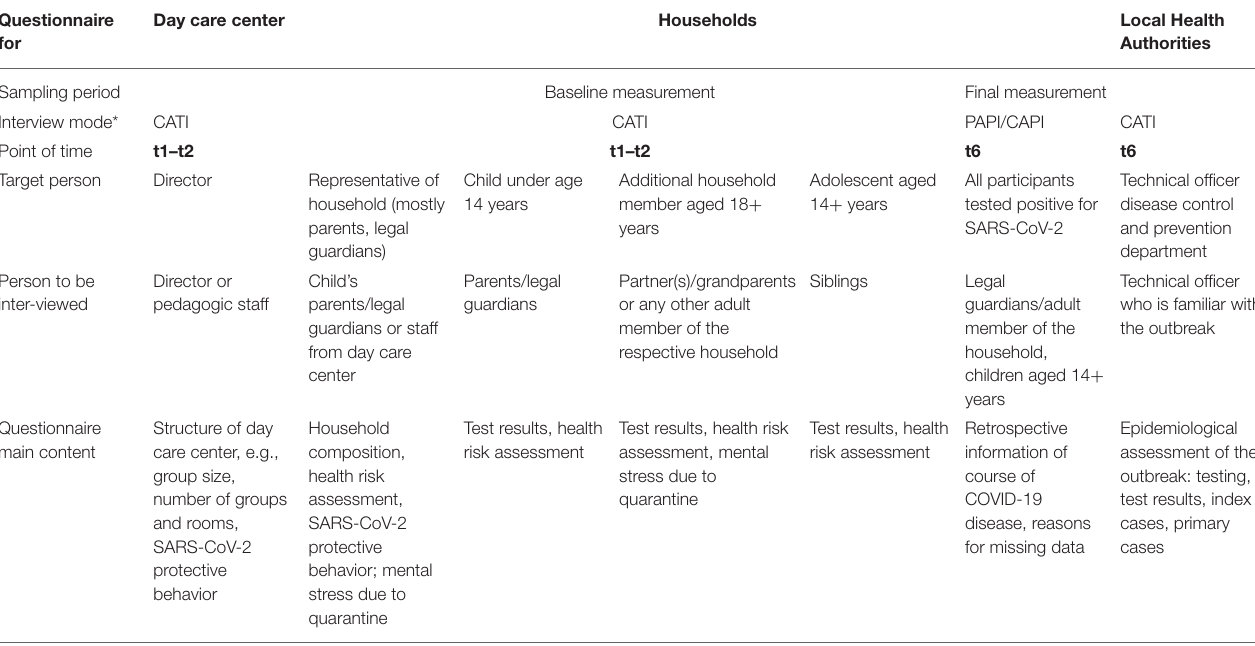
TABLE 2 | Overview of questionnaires in